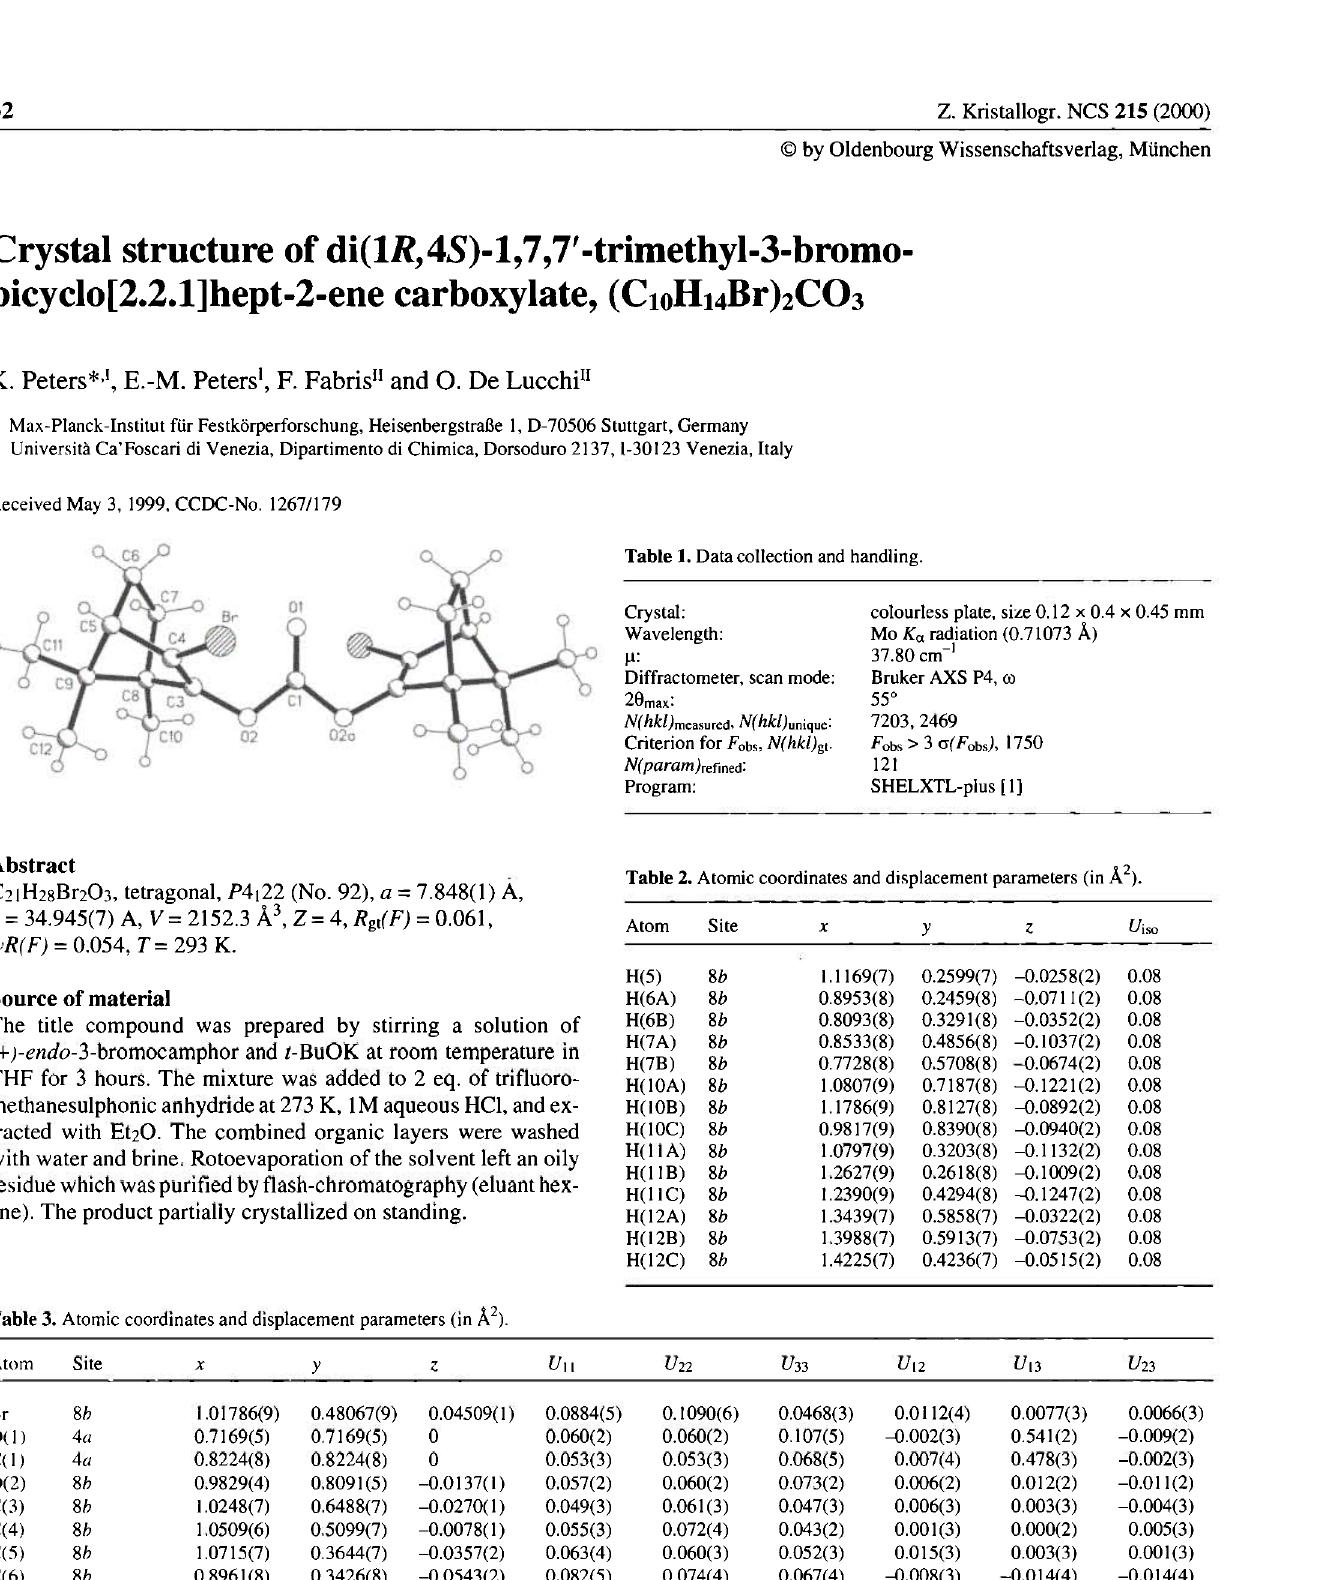
Table 3. Atomic coordinates and displacement parameters (in Ä 2 ).